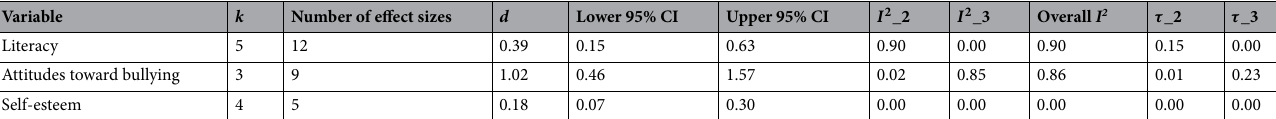
Table 2. Primary meta-analyses of the effect of peer-led interventions on leaders’ outcomes.